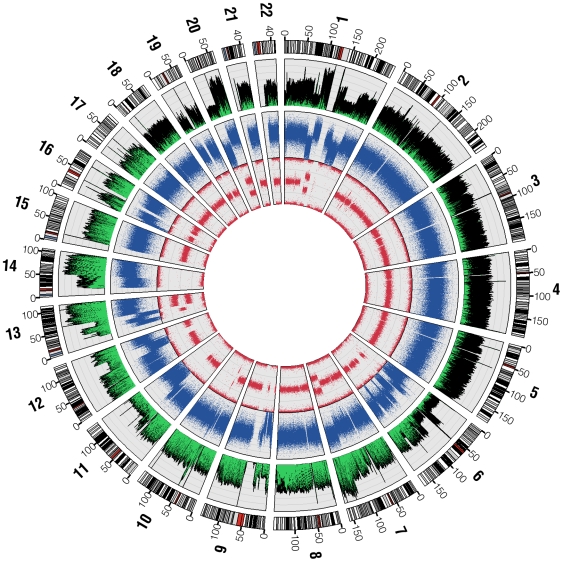
SNP chip and base sequence coverage compared.Circos [36] was used to plot base sequence coverage from ABI sequencing as a histogram (the outermost plot, green and black) alongside dot plots of the LogR-ratio (middle plot, blue) and B-allele frequency (innermost plot, red) from the Illumina Human 1M Duo BeadChip microarray. LogR-ratio represents copy number (CN) and B-allele frequency represents loss of heterozygosity (LOH).